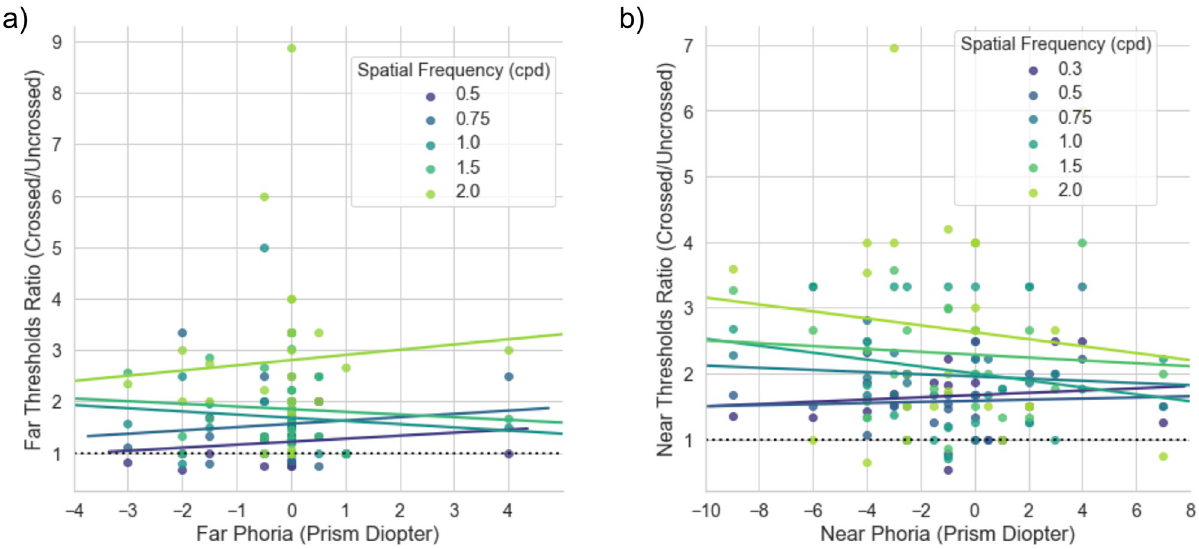
Fig 5. Scatterplots of the ratio of crossed/uncrossed disparity as a function of heterophoria. A negative value on the x-axis indicates the exophoria in prism diopters while a positive value for esophoria. A ratio of > 1 indicates superior sensitivity to the crossed disparity. The different color hues represent the ratio at different spatial frequencies. a) Result for far phoria. We do not see any correlation between far phoria to directional bias. b) Result for the near phoria. Similarly, we do not see any correlation pattern between near phoria and directional bias. The horizontal dotted line indicates the ratio of 1:1, where stereo threshold for crossed and uncrossed disparity is equivalent. Note that the scales on the axes are different between the two